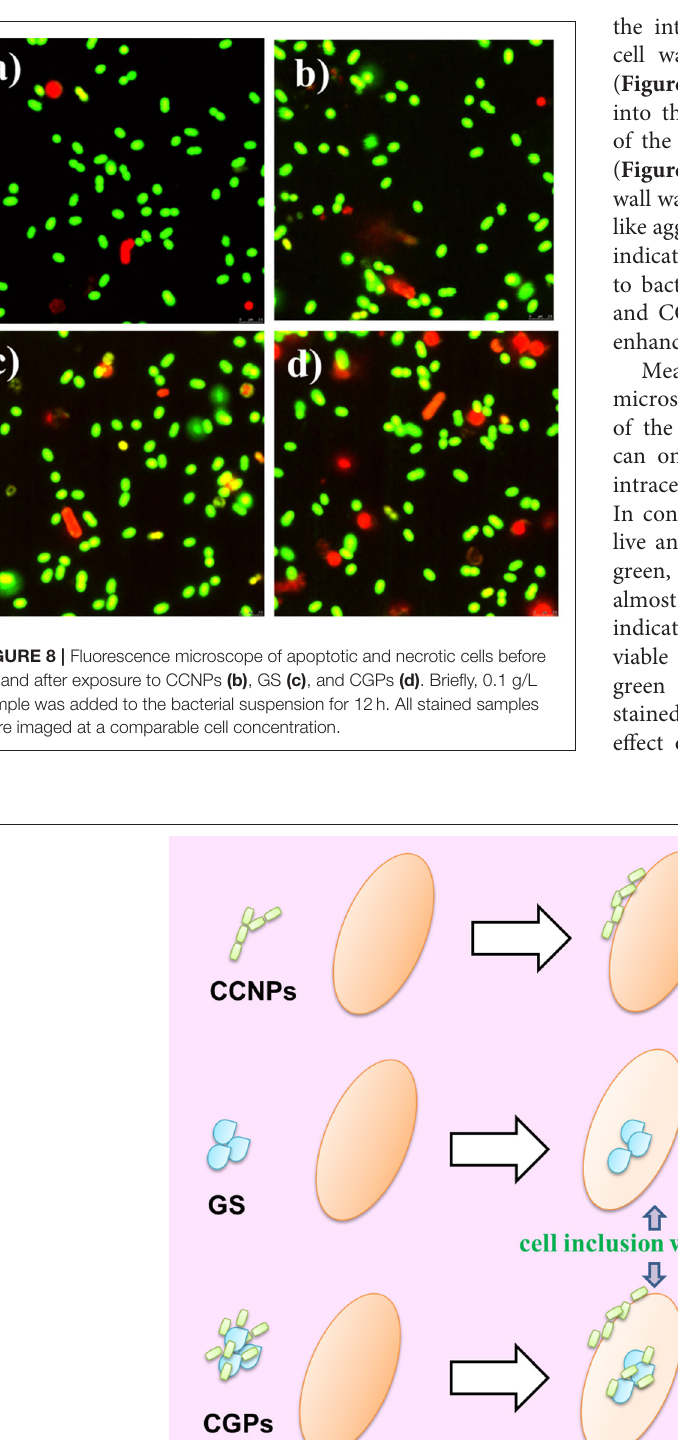
Frontiers in Chemistry |